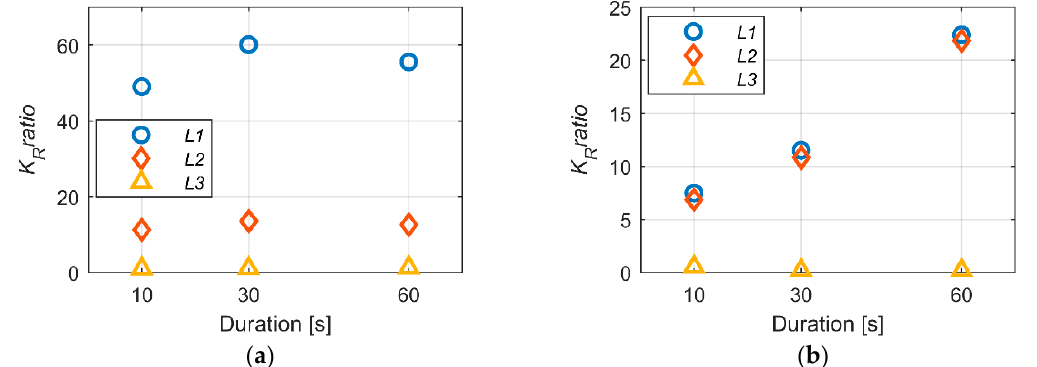
Figure 10. K R ratio as function of the acquisition duration for Aax signals: ( a ) Test-1; ( b ) Test-2.